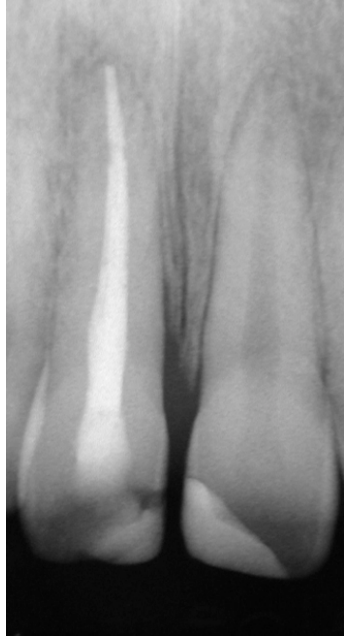
Figure 5. Rx at the 3-month recall visit.